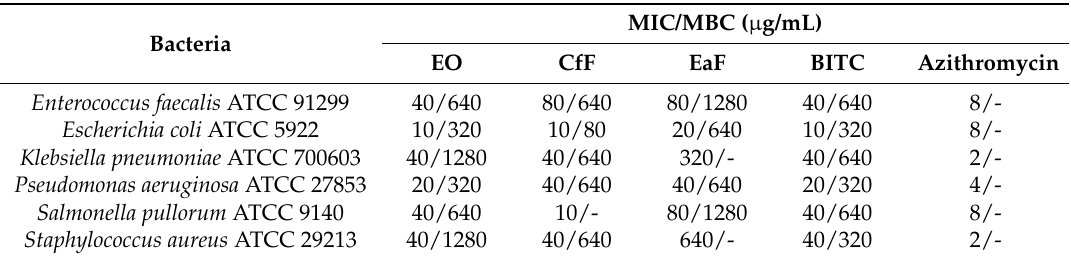
Table 1. Antibacterial activity of the essential oil and fractions from the crude extract (CE) of T. pentaphyllum